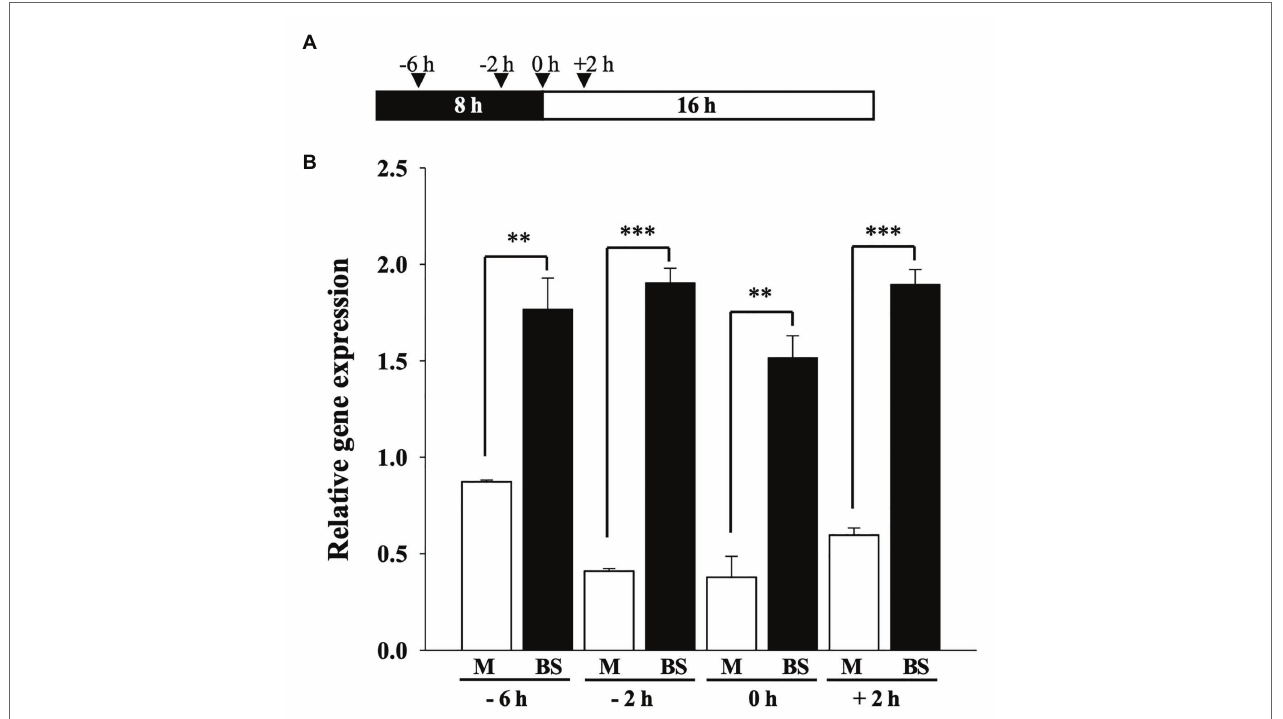
FIGURE 6 | Analysis of ZmOrphan94 transcript level in mesophyll (M) and bundle sheath (BS) cells. (A) Schematic representation of the sampling time points. Black and white box indicate dark and light period, respectively. Arrowheads indicate sampling points. (B) ZmOrphan94 expression in BS and M cells in the analyzed time points. ZmOrphan94 transcript levels were analyzed by RT-qPCR and normalized against the expression of two housekeeping genes (GRMZM2G144843 and GRMZM2G044552). Data represent means ± SEM ( n = 3). Statistical significance ( t -test, ** p < 0.01 and *** p <